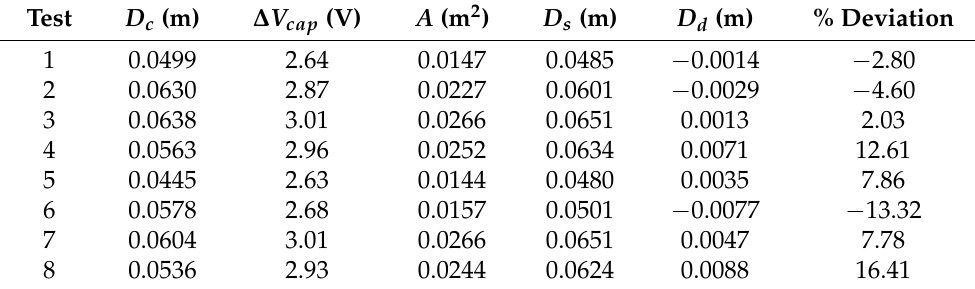
Figure 15. Single sensor results: ( a ) sensor voltage drop; ( b ) contact time comparison for sensor and high-speed camera. Table 3. Single sensor